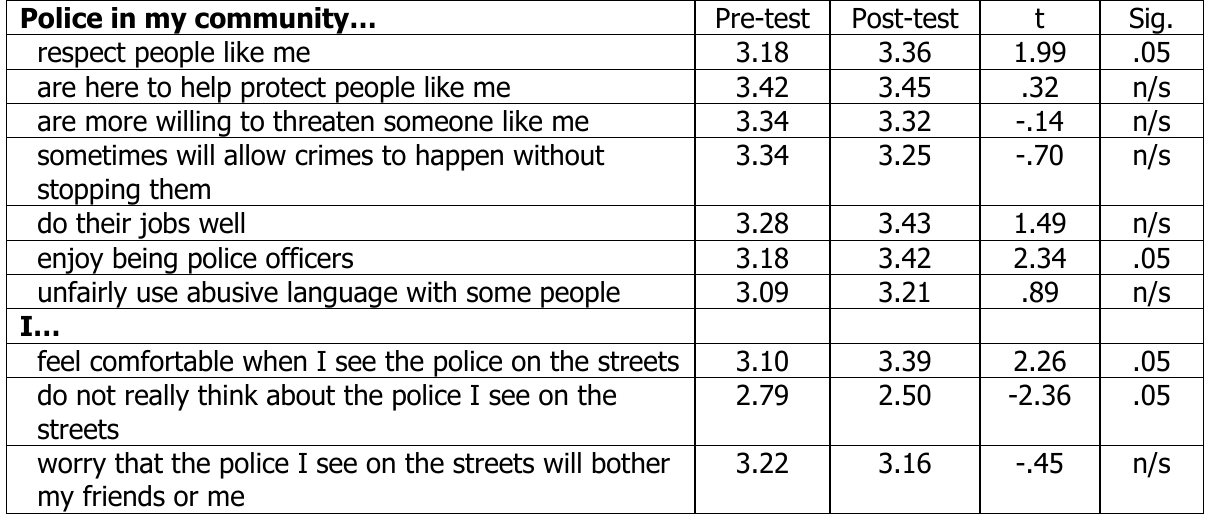
Average Scores on Each Item Pertaining to Youth’s Attitudes toward the Police